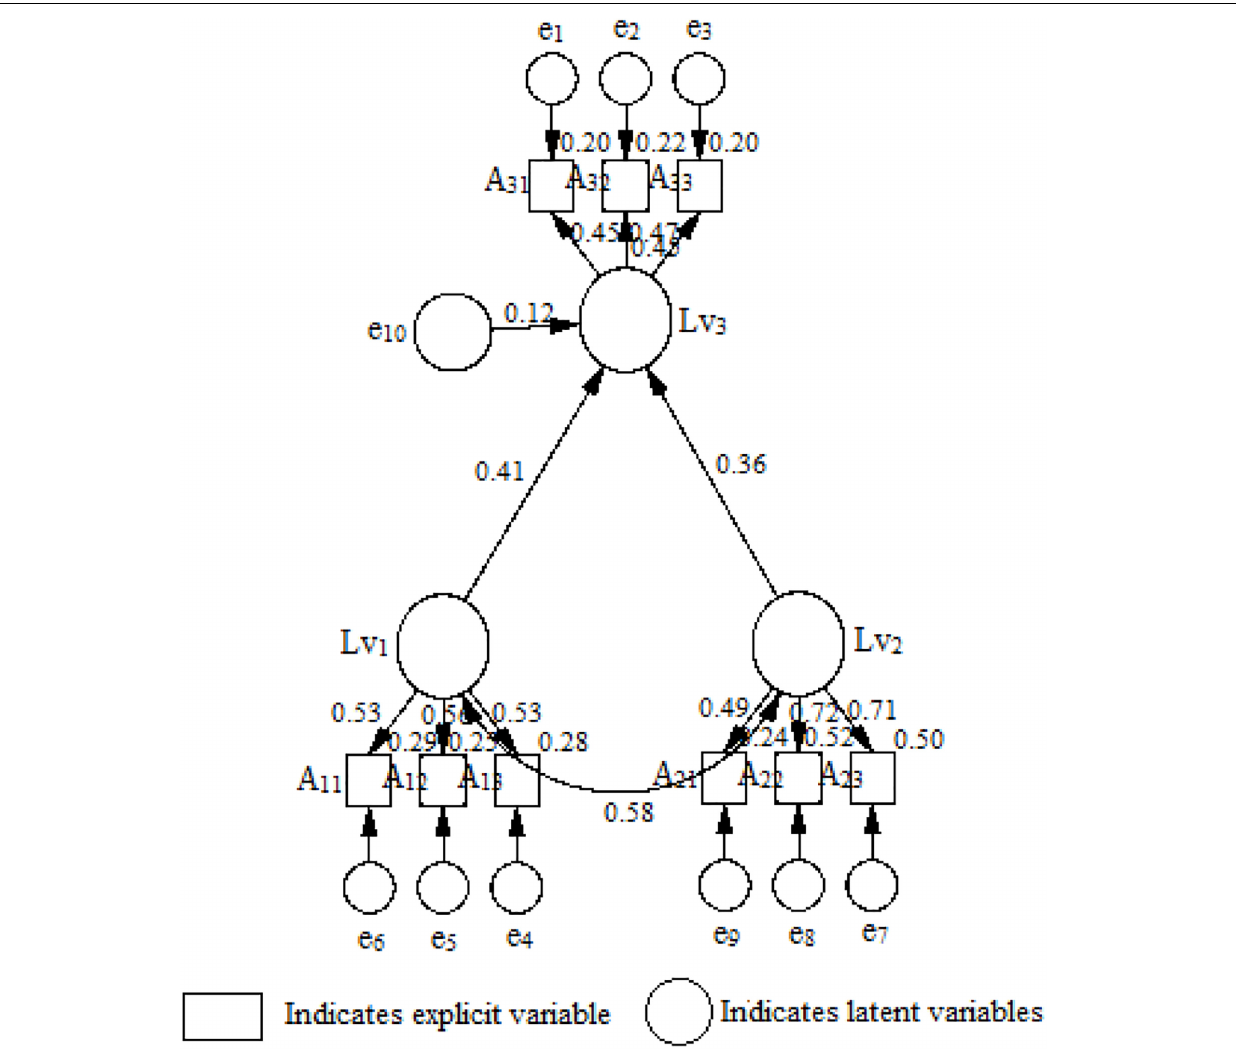
Frontiers in Energy Research |